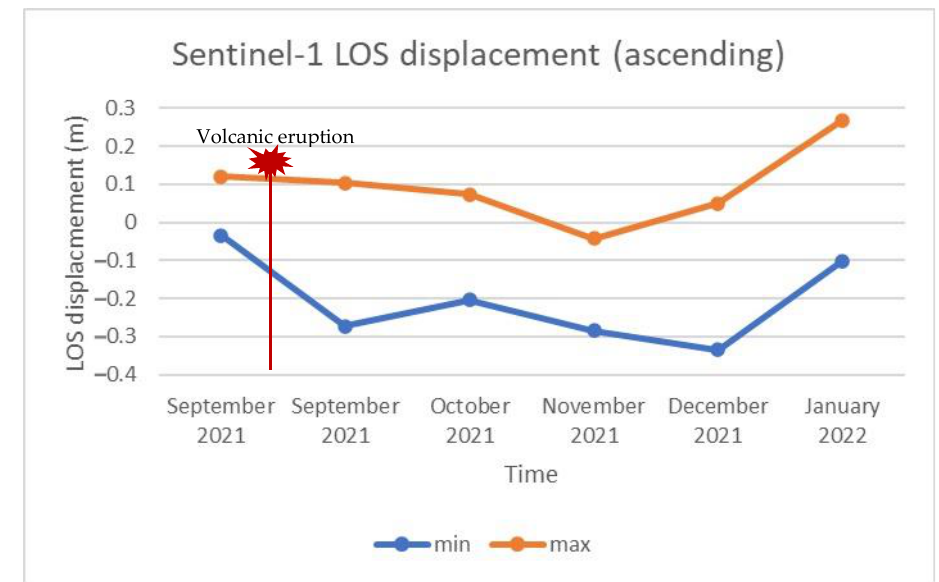
Figure 8. Multitemporal LOS displacement over the entire eruptive period, obtained by processing the Sentinel-1 ascending imagery.